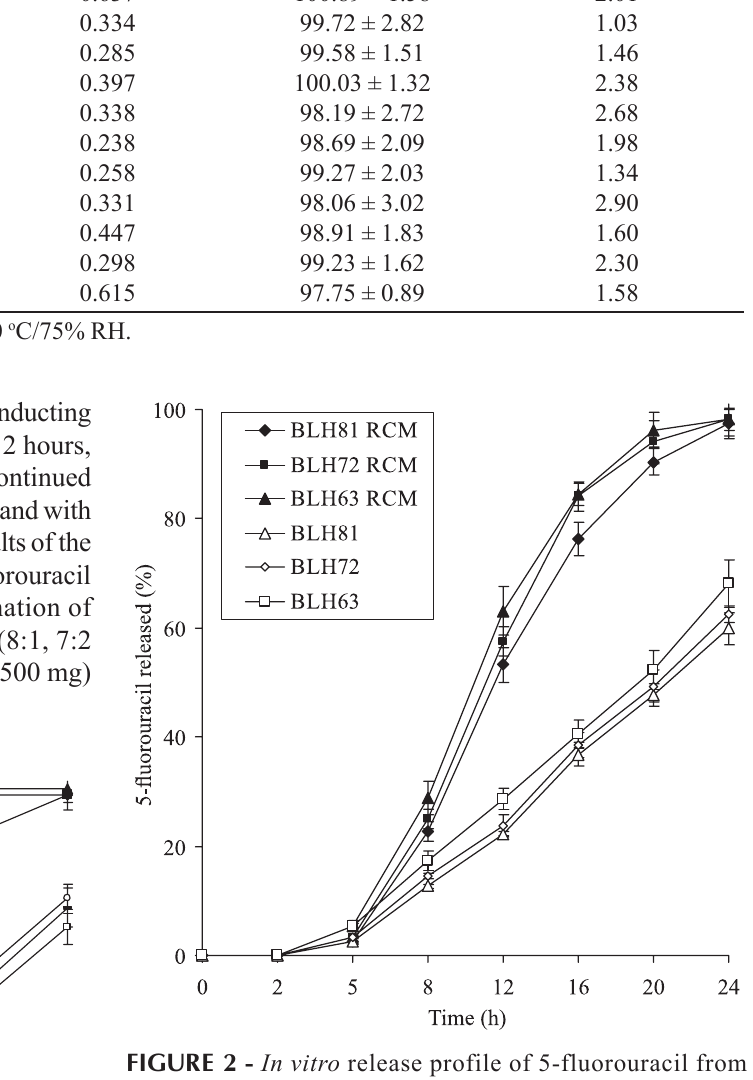
FIGURE 2 - In vitro release profile of 5-fluorouracil from formulation coated with 400 mg without and with rat caecal medium